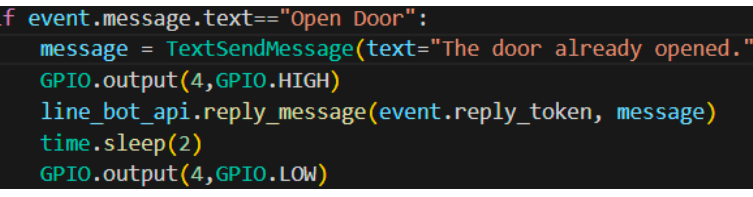
Figure 13. The screenshot of the resident’s smartphone.